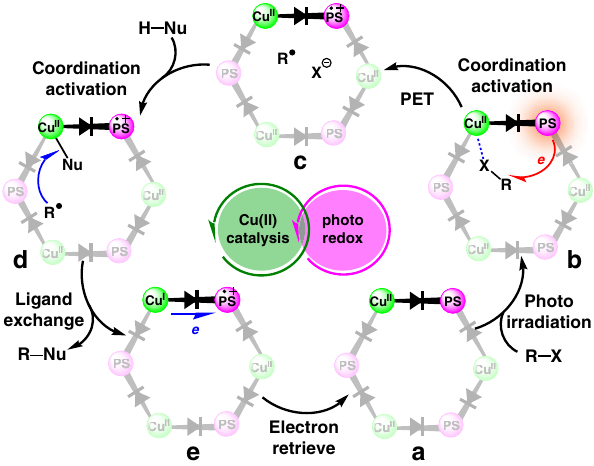
Fig. 7 Proposed mechanism of synergistic photoredox and copper catalysis by Cu – Twisted. The schematic illustrations of a initial state of Cu – Twisted , b PET process from TPA -moiety to the radical precursor that activated by Cu(II) site, c in situ generated alkyl radical within framework, d inner-spheric redox process between the alkyl radical and the nucleophile that coordinated to Cu(II) site, and e retrieval of electron from Cu(I) to radical cation form of TPA